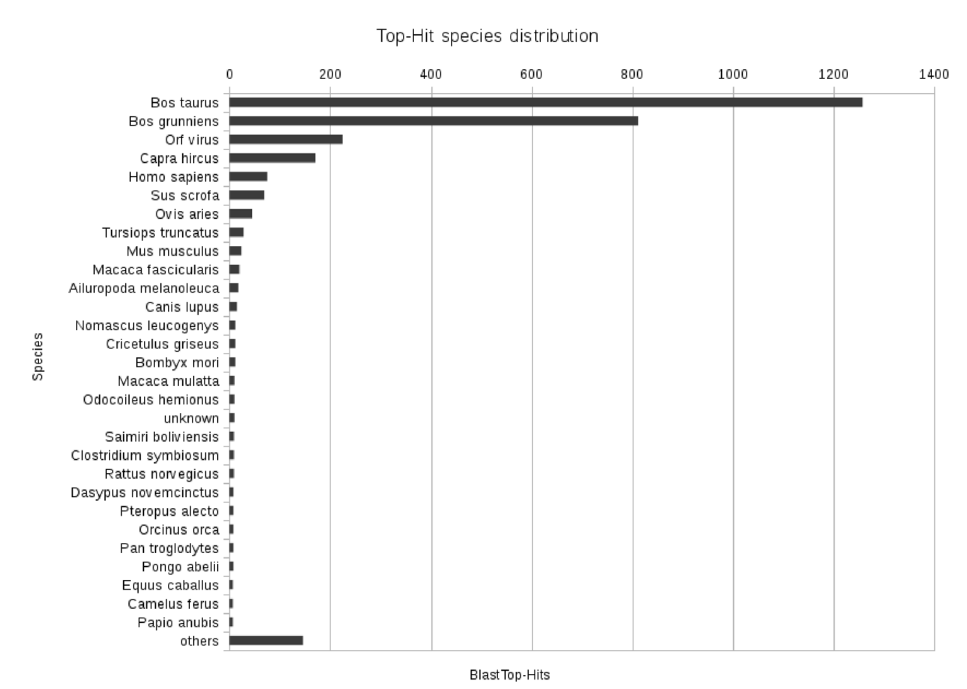
Fig. 3. Distribution of unknown transcripts that did not align to the ovine genes in Ensembl database.